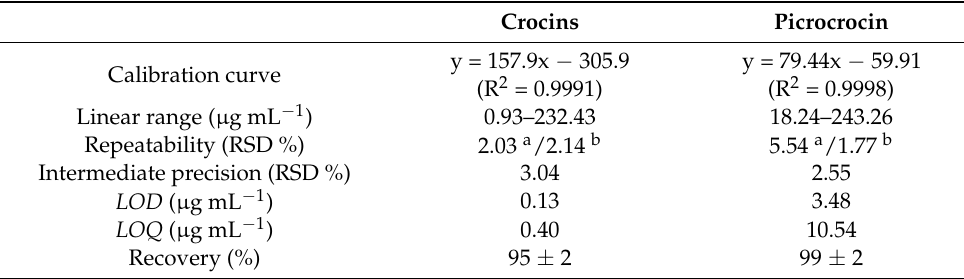
Table 2. Analytical parameters for the validation of the LC-DAD method for crocins and picrocrocin determination.